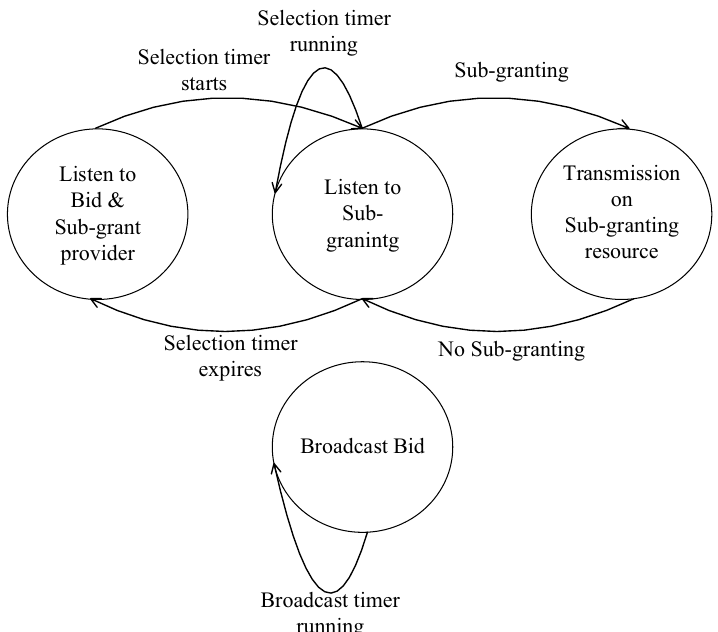
Fig. 3 State‑machine diagram of a beneficiary user functionality on the open sub‑granting